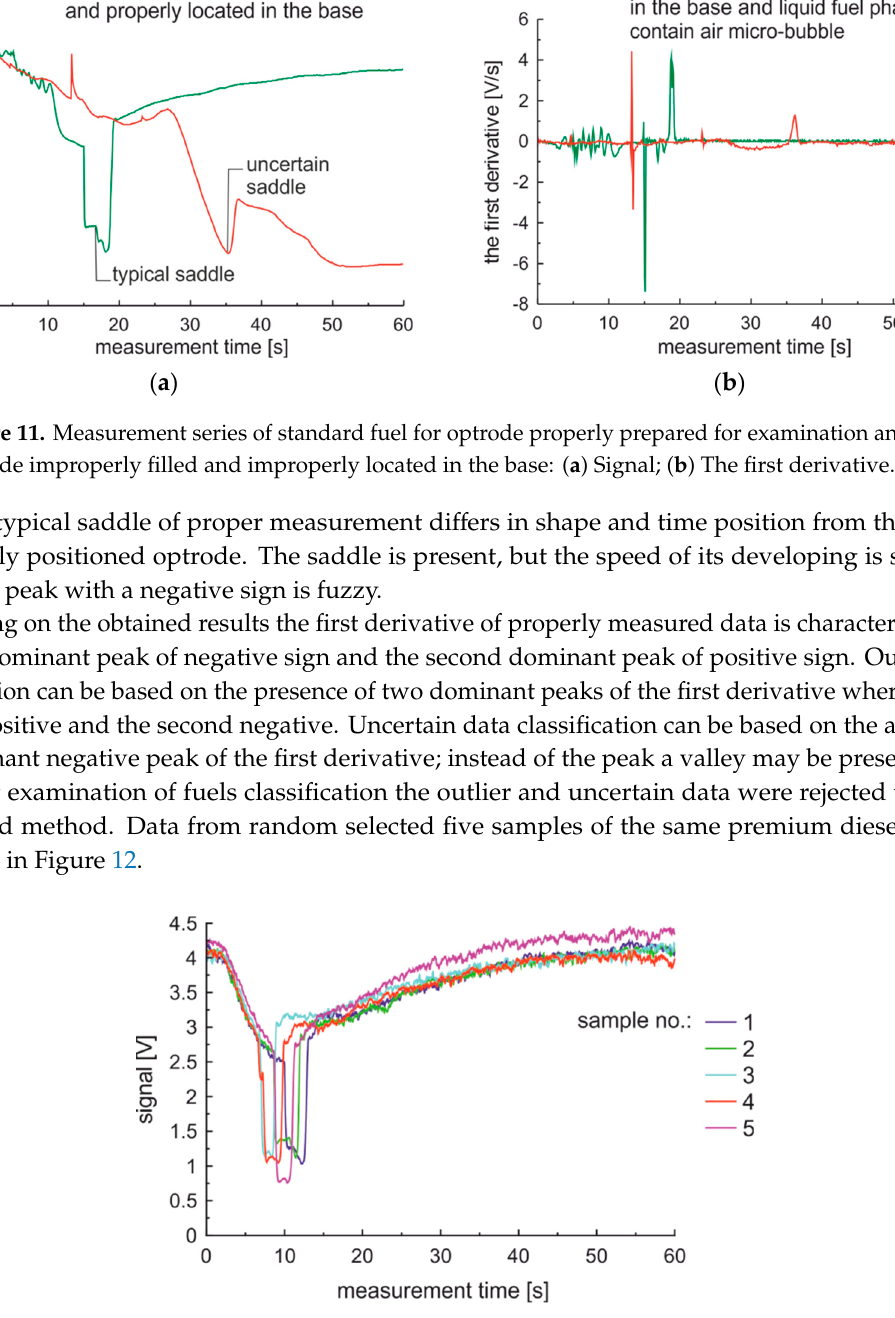
Figure 12. Data collected for five samples of the same premium diesel fuel.